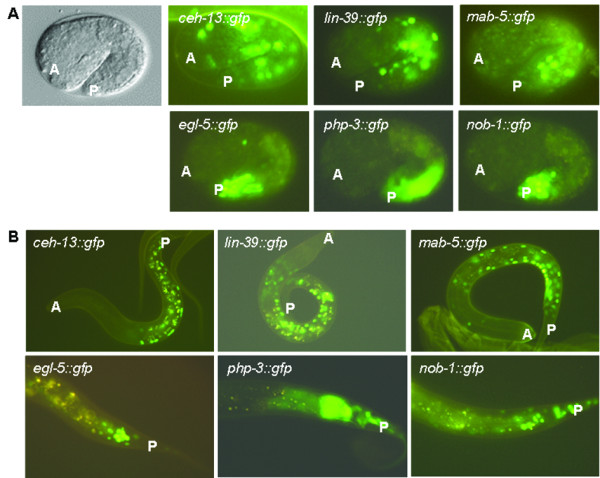
The expression domain of ceh-13 overlaps with that of the other Hox paralogs. A, Fluorescence images showing the expression of the C. elegans Hox genes at the two-fold embryonic stage. ceh-13 expression runs all along the anteroposterior body axis, ranging from head-to-tail. A: anterior, P: posterior. B, Expression of the C. elegans Hox genes at the L1 larval stage. Specimens transgenic for a posterior Hox paralog are shown only at the tail region (the bottom panels). A: anterior, P: posterior.